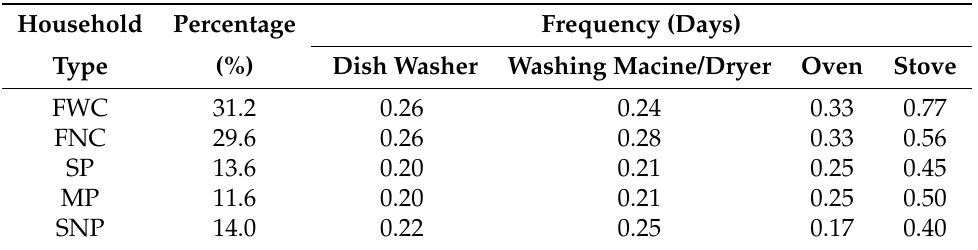
Table 2. Data for appliance use for different types of households. FWC, family with children; FNC,